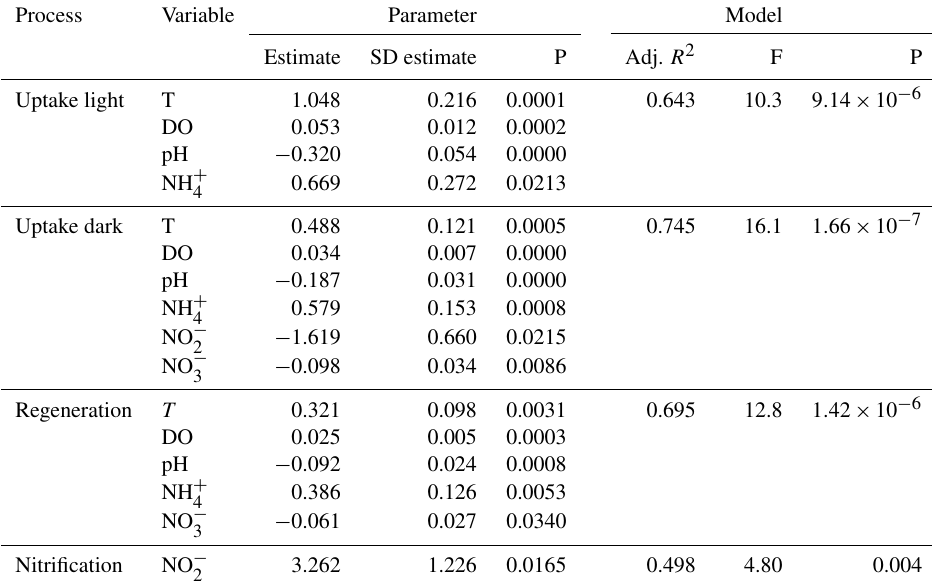
Table 4. Details of best-fitting multiple-regression models determined by stepwise regression. All rates, temperature, and ambient nutrient concentrations were log-transformed prior to